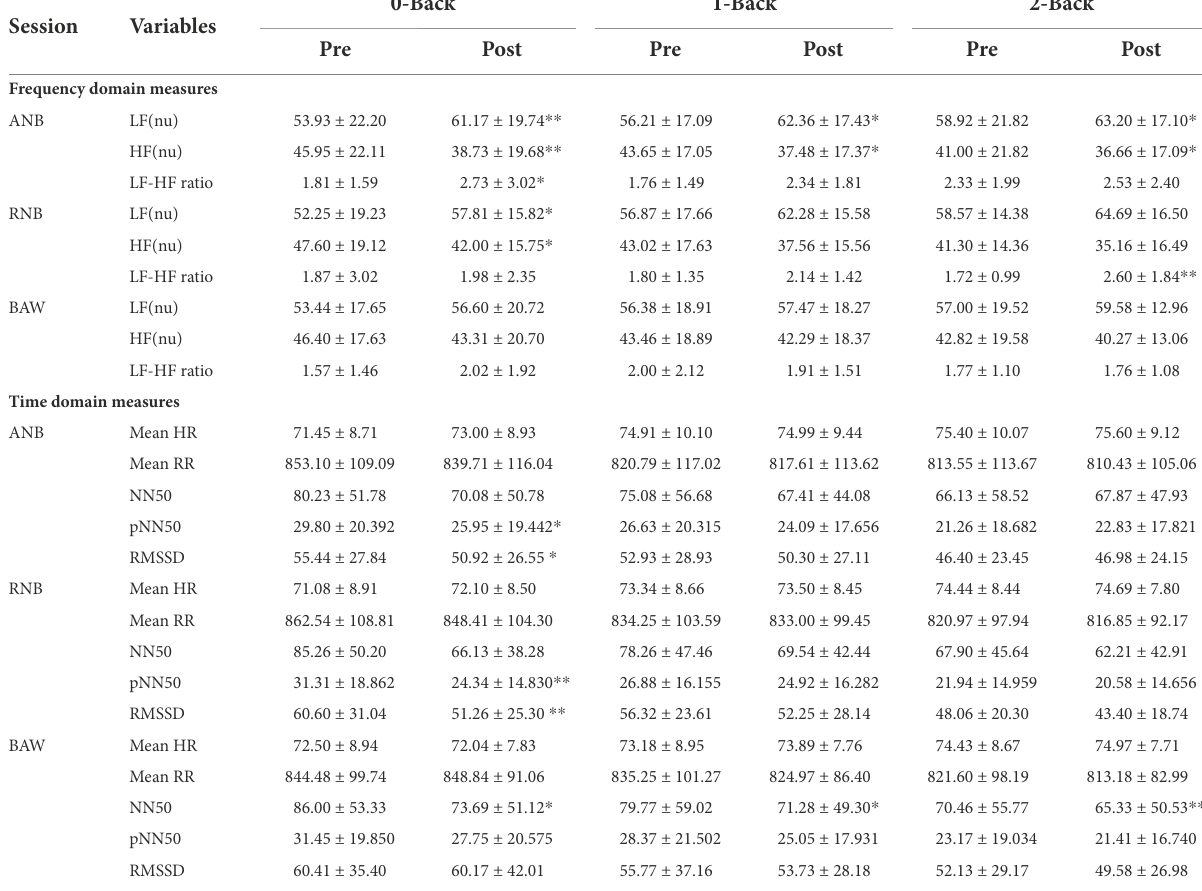
TABLE 2 HRV measures during an n-back performance before and after yoga breathing. Values are group mean ± SD (n = 40). 0-Back 1-Back Session Variables